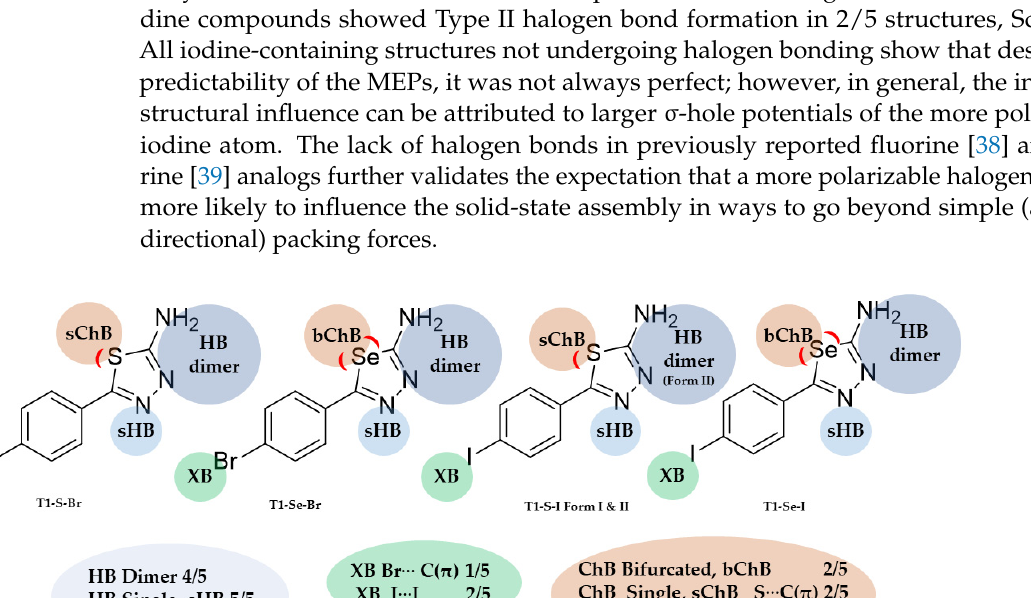
Figure 9. Distribution of torsion angles based on 152 CSD-reported 1,3,4-thiadiazol